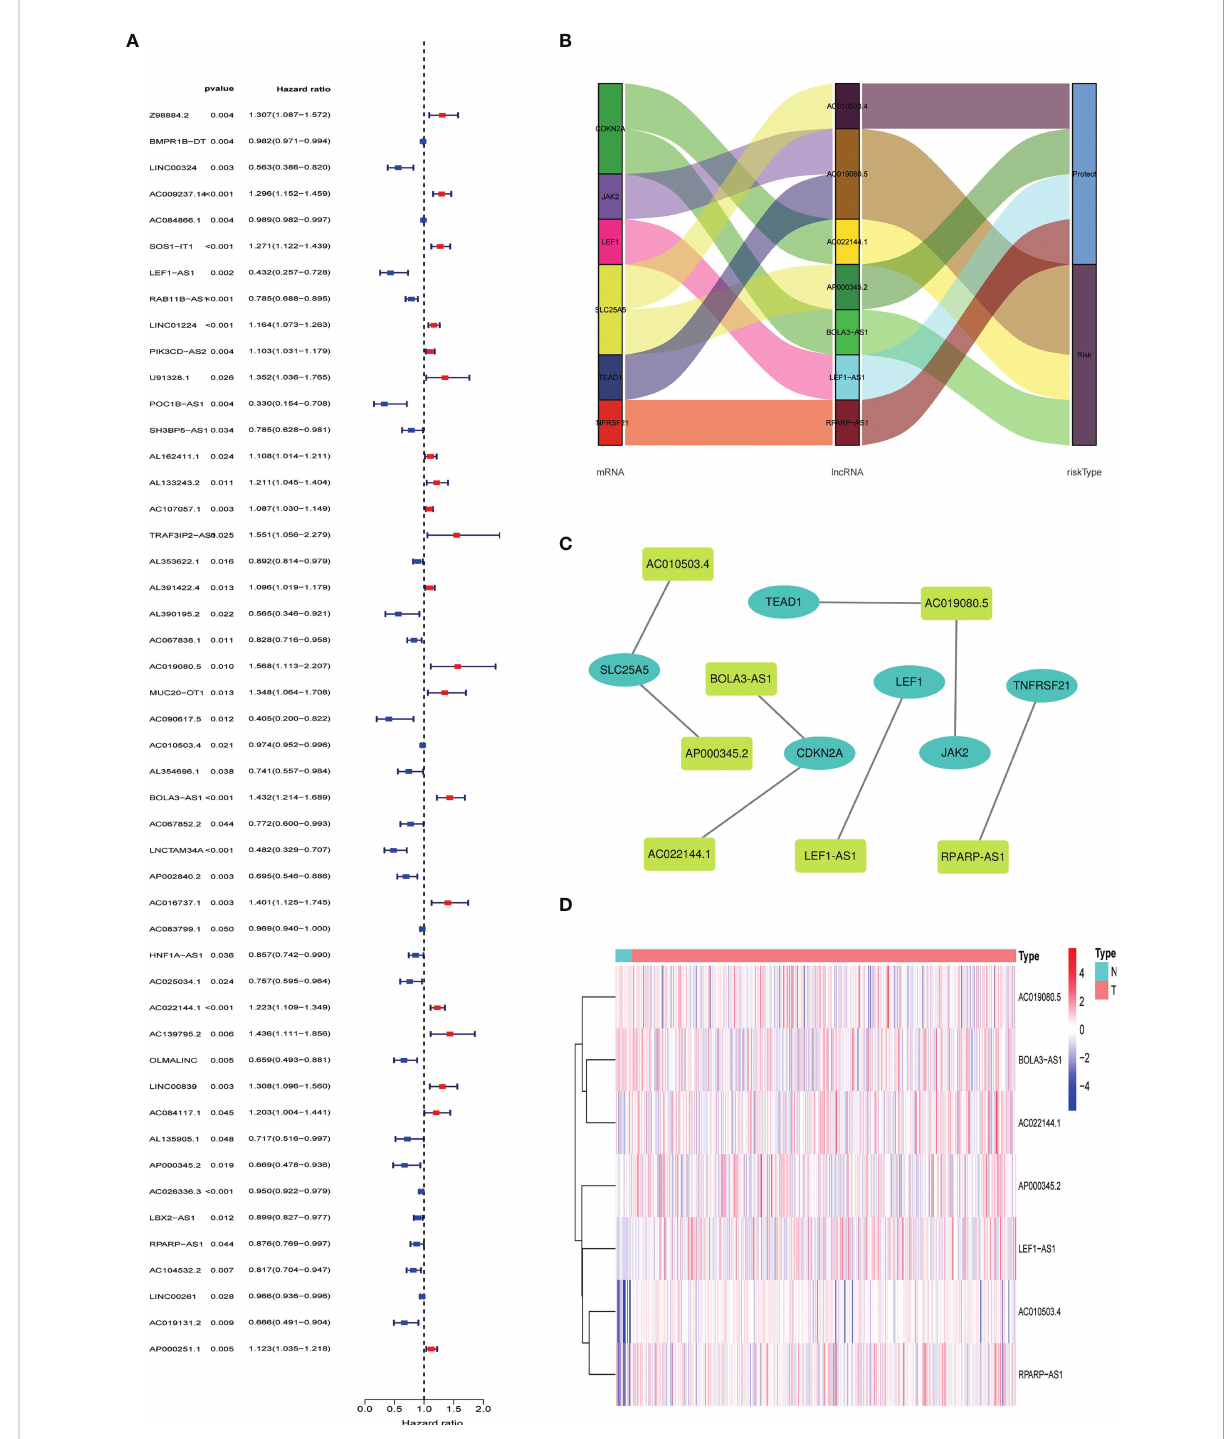
FIGURE 5 Nomogram for predicting overall survival (OS). (A) A prognostic nomogram combining risk score with clinicopathological variables for predicting 1-, 3-, and 5-year OS in EC patients. (B – D) The calibration curves of the nomogram con fi rming consistency between the predicted 1-, 3-, and 5-year survival rates and the actual OS